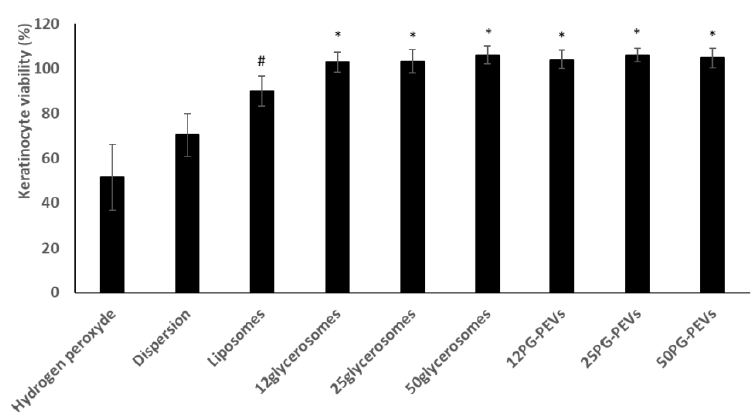
Figure 2. Viability of keratinocytes stressed with hydrogen peroxide and simultaneously treated with the pompia extract in dispersion or loaded in the vesicular formulations. Mean values ± standard deviations are reported. # and * symbols indicate statistical differences between samples.